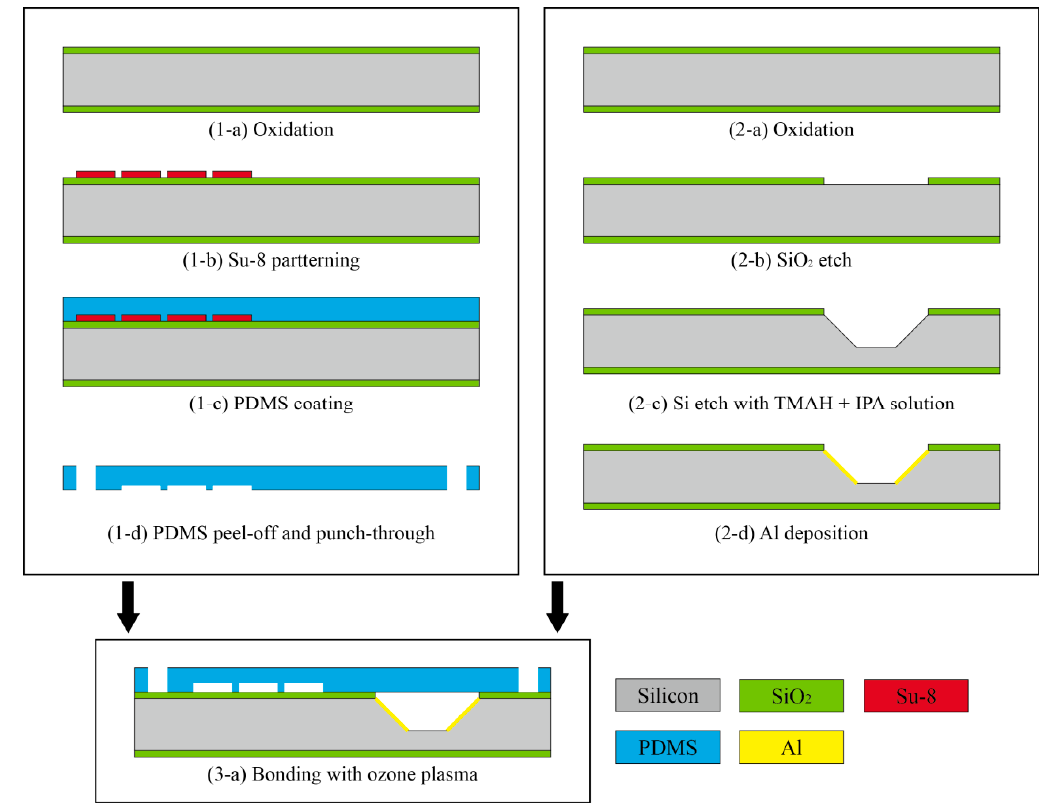
Figure 5. The fabrication process of the proposed LOC-based non-invasive optical sensor for measuring glucose in saliva.